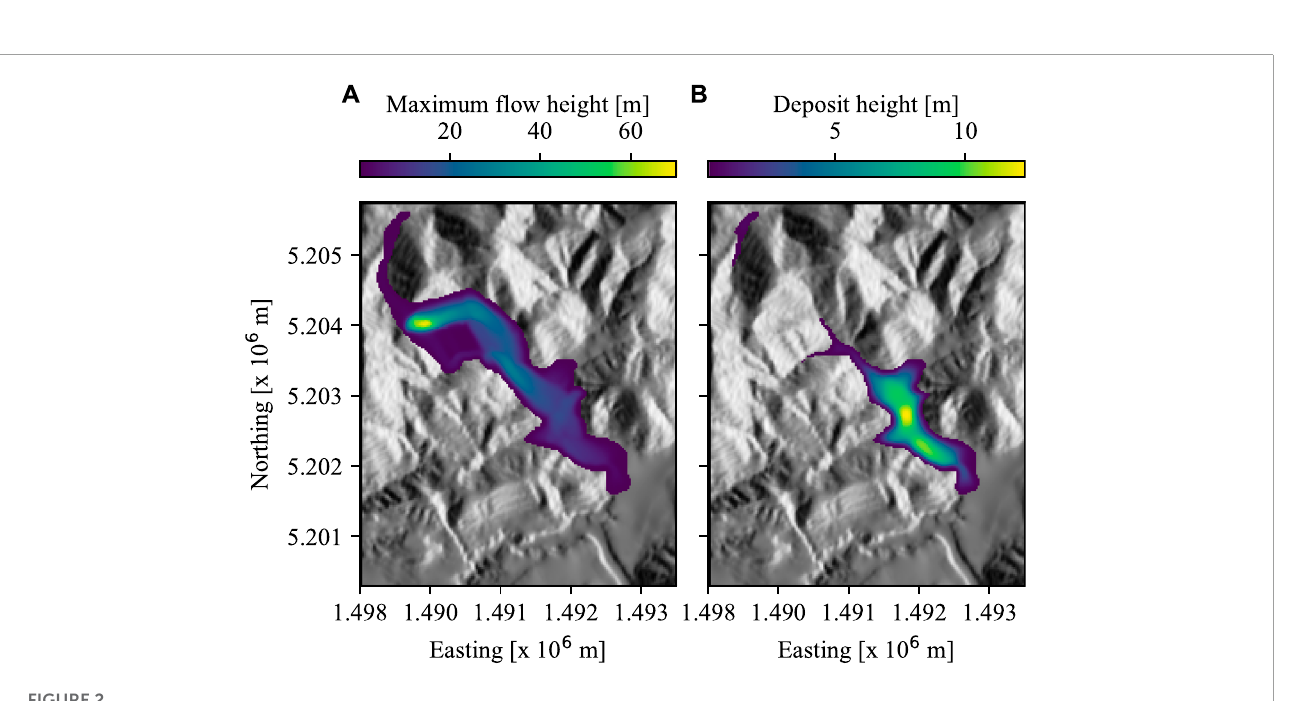
FIGURE 2 (A) Maximum flow height and (B) deposit height from a simulation of Acheron rock